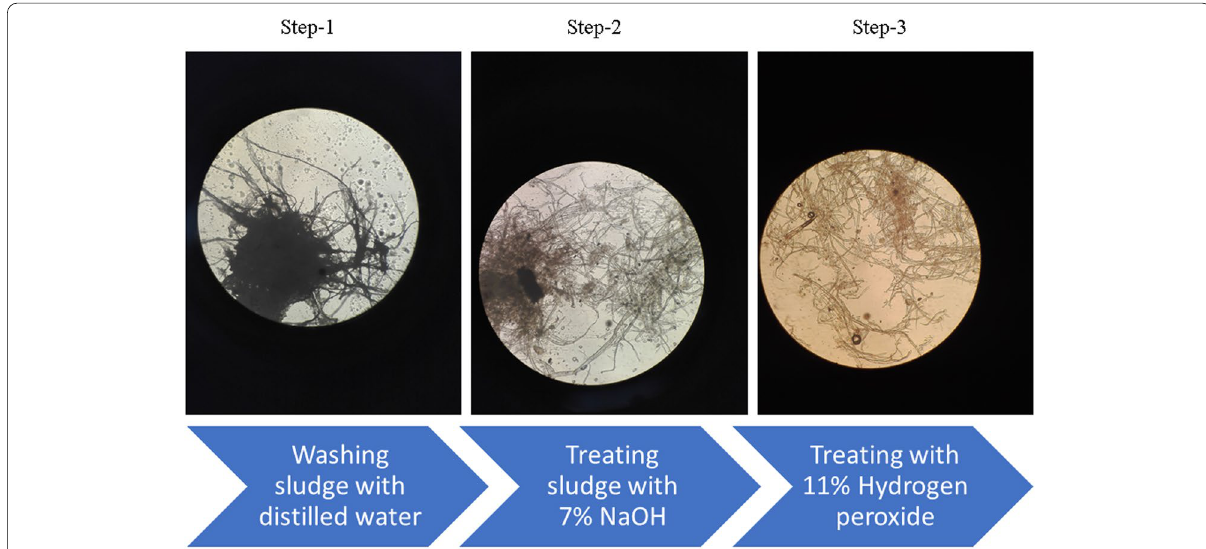
Fig. 7 Structural changes of paper sludge throughout chemical treatment process observed under microscope at 10 ⨯ magnification. Filamentous parts indicate cellulosic fiber sequentially getting loosened and accessible